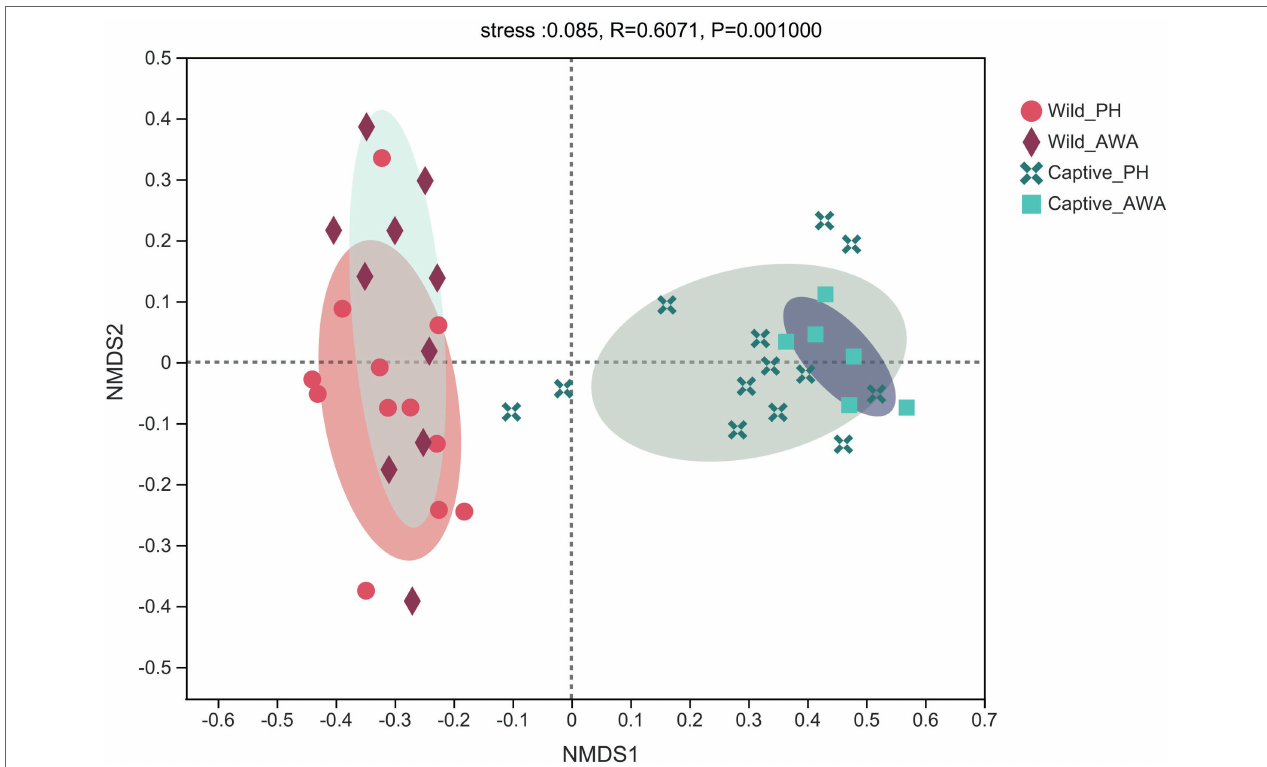
FIGURE 3 | Non-metric multidimensional scaling (NMDS) plot of the gut microbiota in equids on the OTU level. The closer the points, the more similar of microbial community